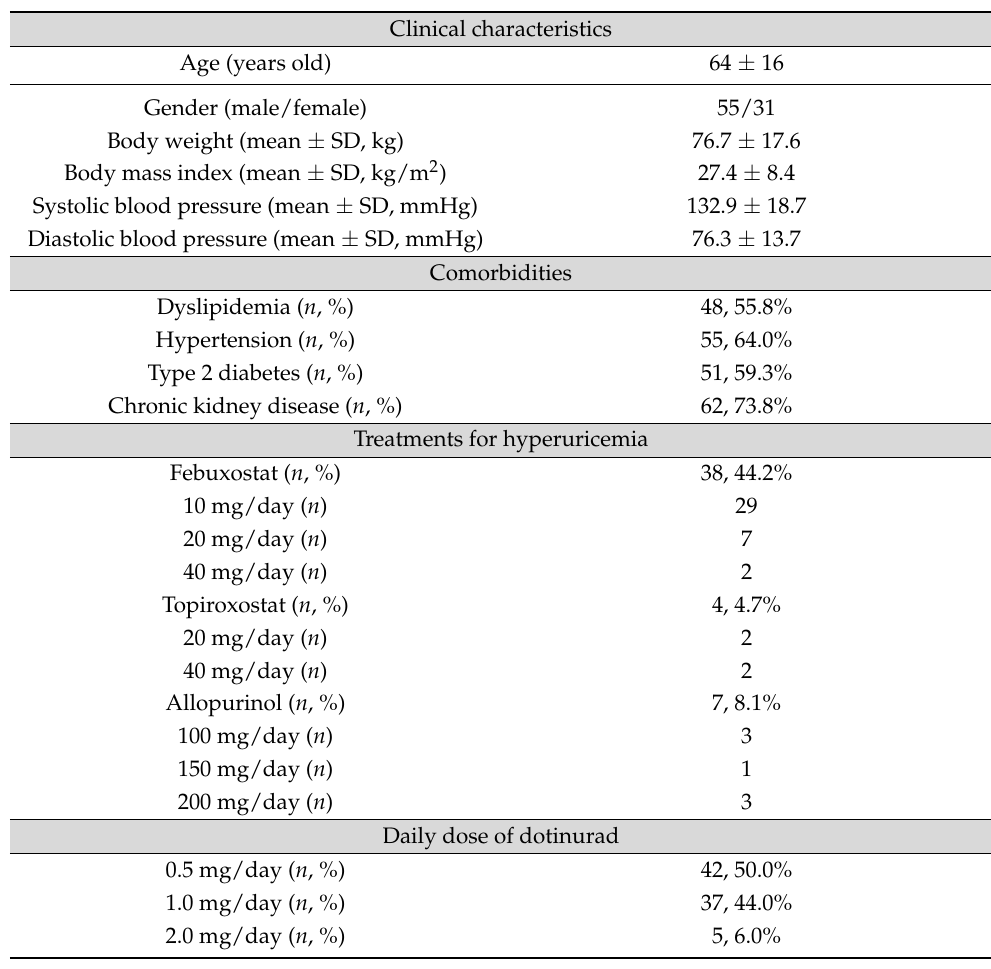
Table 1. Baseline characteristics for patients who had taken dotinurad ( n = 84). Clinical